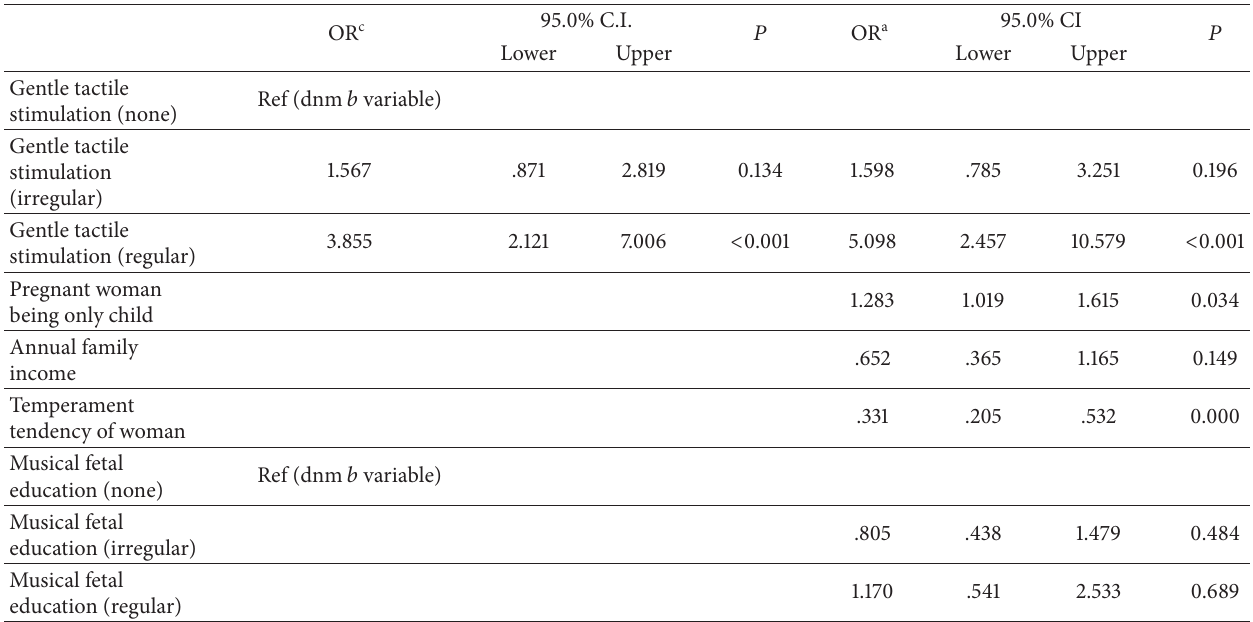
Table 4: The results of logistic multivariable analysis of infant temperament type on independent factors ( 𝑁 = 300 b